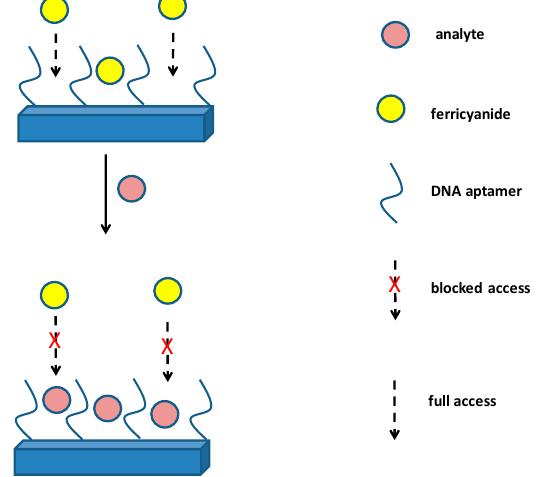
Figure 3. Principle of impedimetric sensor with immobilized ssDNA working on principle when a redox active compound, such as ferricyanide (3-), has limited access to electrode surface. This principle was for instance introduced in the work by Mazzaracchio et al. [77].